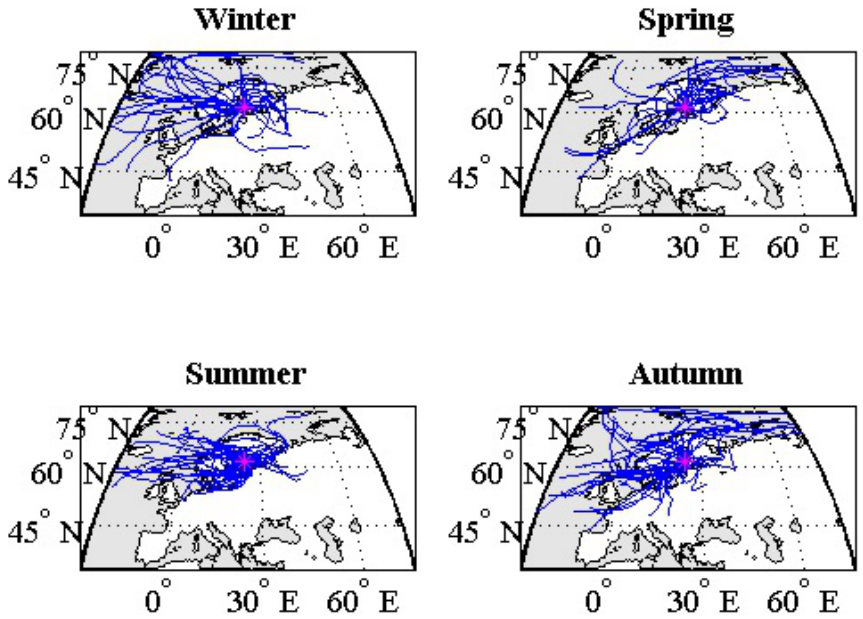
Fig. 13. Seasonal 4-day air mass back trajectories arriving at Hyyti¨al¨a (2005) for the samples where REMO-HAM is severely (more than 300ngm − 3 ) underestimating the